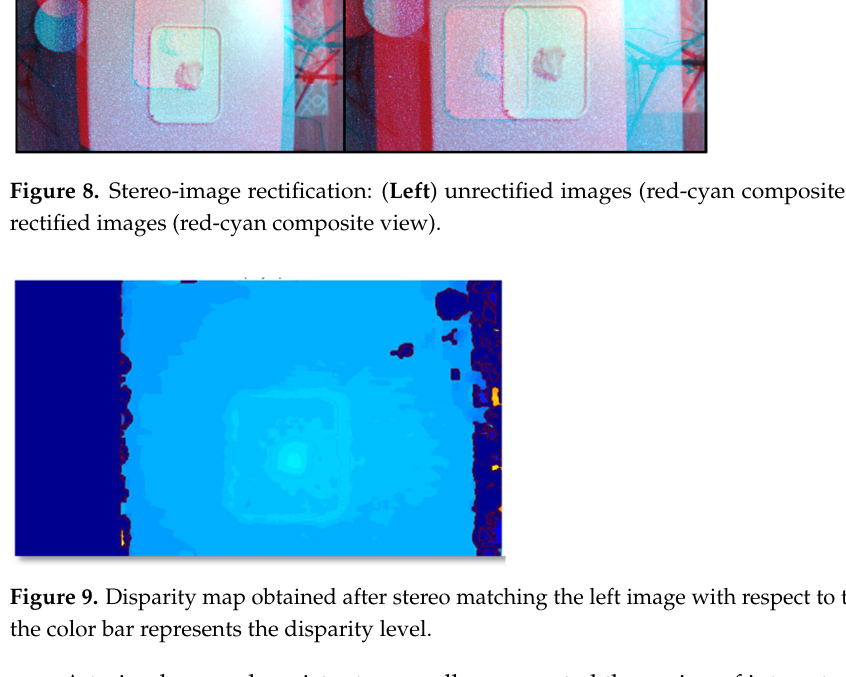
Figure 7. Grayscale image capture by the Pico Flexx camera.